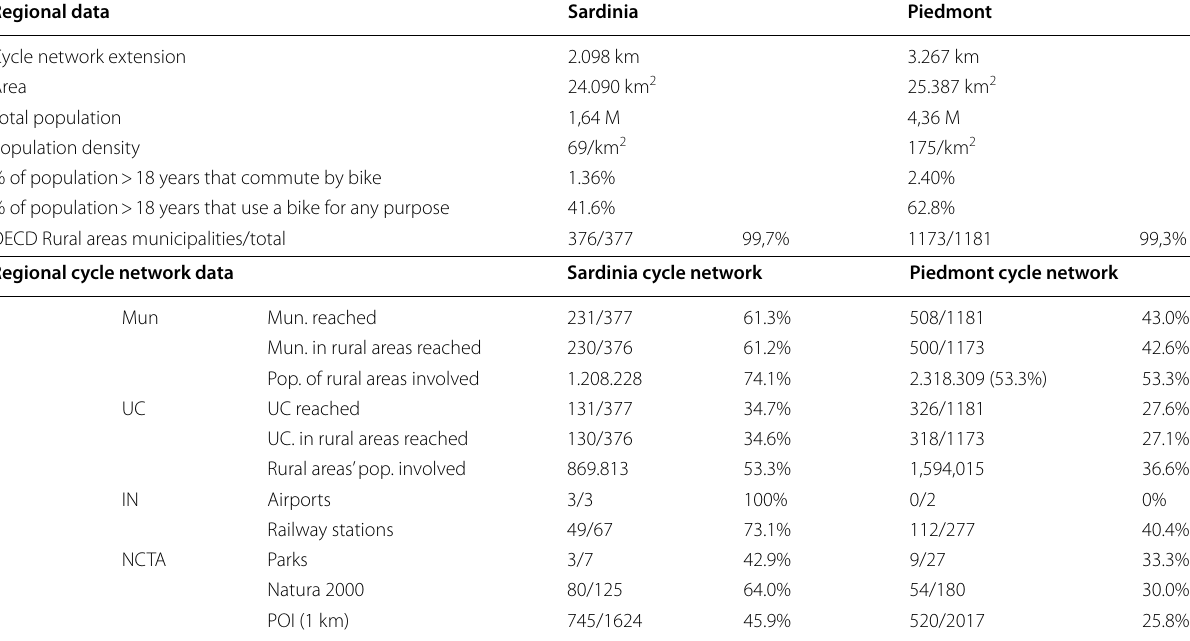
M million, Mun. municipalities, Pop. population, UC urban centres, IN intermodal nodes, NCTA natural, cultural, and tourist attractions, POI point of